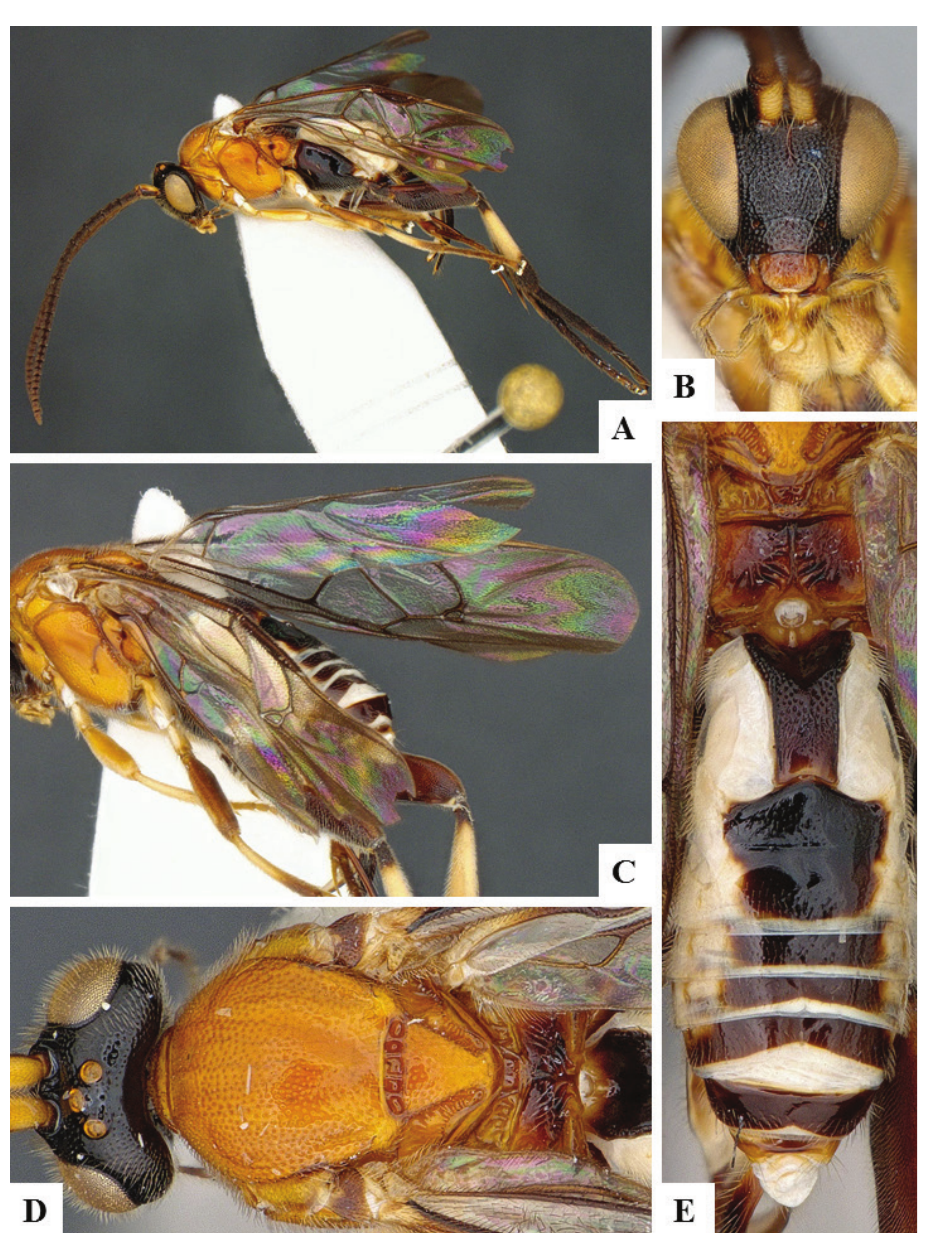
Figure 2. Agupta danyi female paratype CNC497186. A Habitus B Head frontal C Fore wing D Head and mesosoma, dorsal E Propodeum and metasoma,